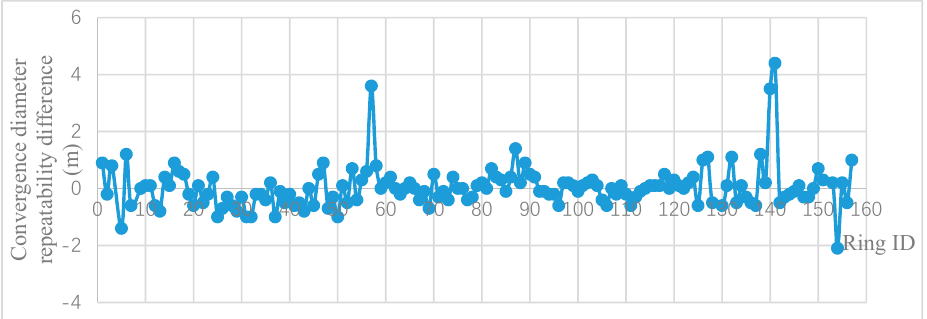
Figure 8. Convergence diameter repeatability difference. Table 2. Statistical table of the twice-repeated measurement